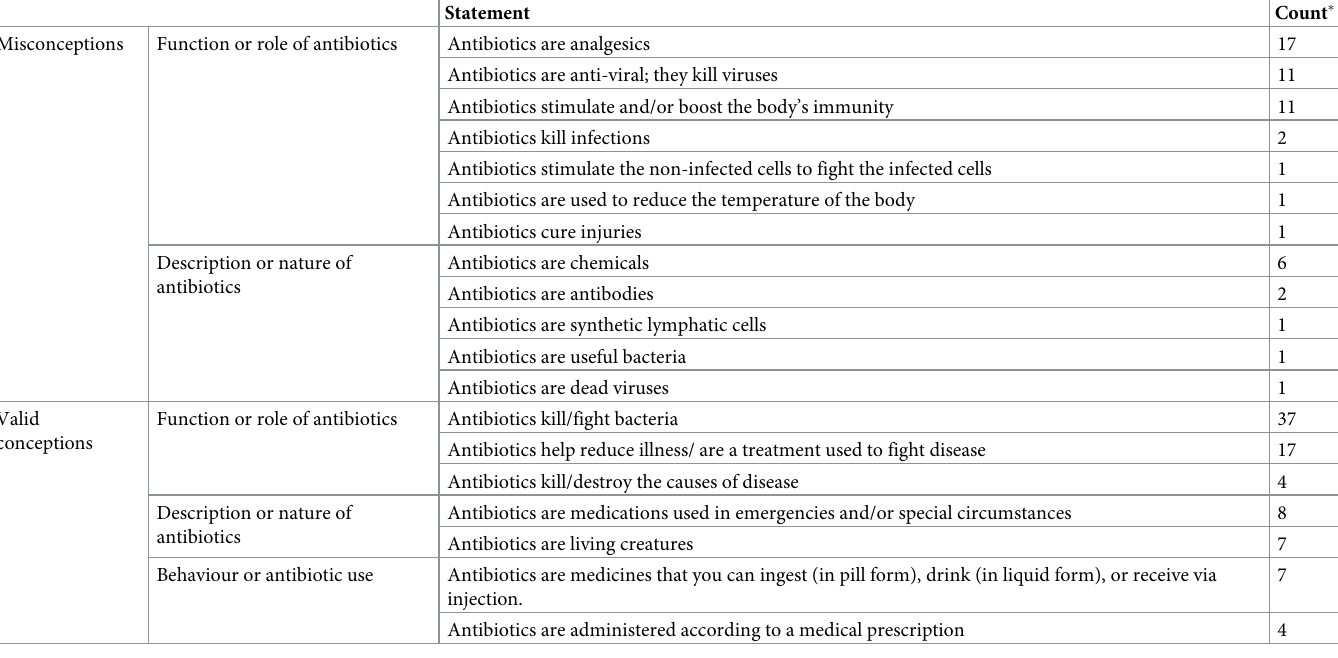
Table 5. Findings pertaining to oral questionnaire Question 1: Can you tell me what you know about antibiotics—what they are and how they